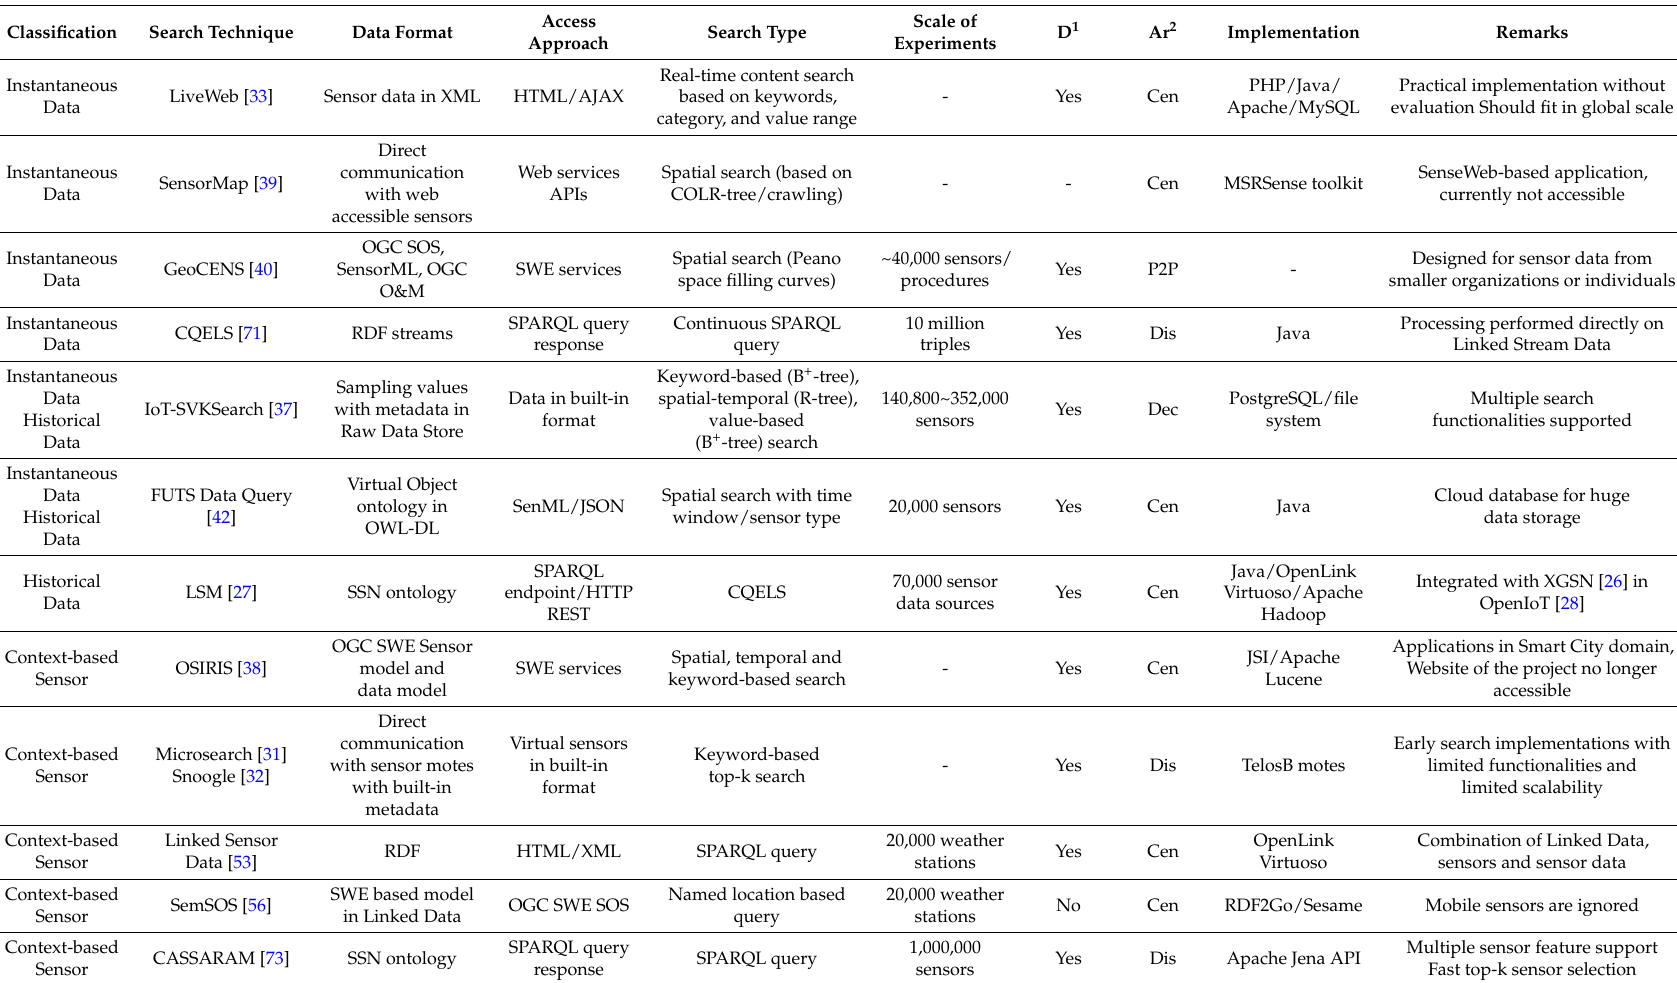
Table 4. Comparison of Search Techniques According to Content being Searched (Abbreviations are listed in the footer of Table